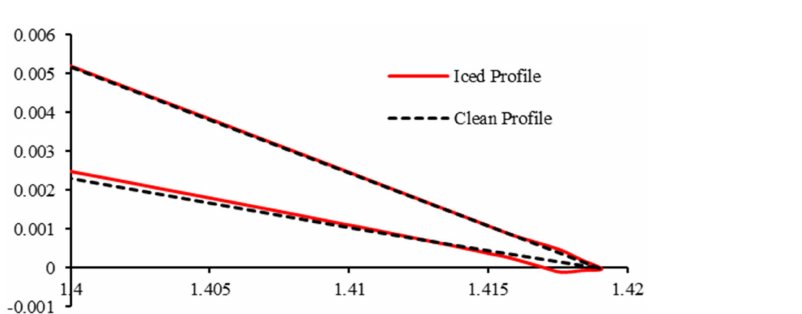
Figure 6. Iced profile vs. clean profile.